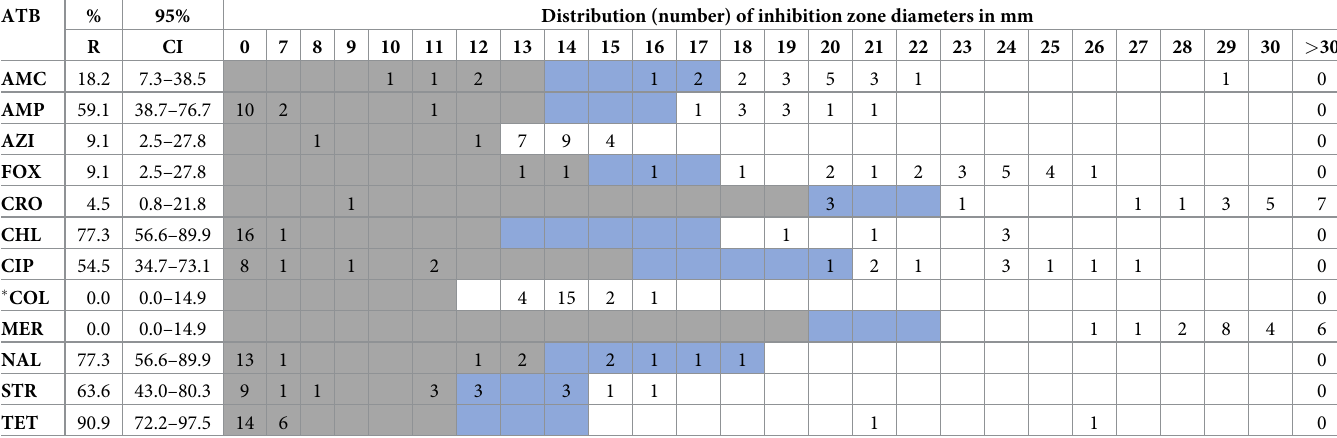
Table 4. Distribution of inhibition zone diameters of presumptive quinolone resistant E . coli (n = 22) isolated on MacConkey agar supplemented with 0.5 μ g/mL of ciprofloxacin. ATB % 95% Distribution (number) of inhibition zone diameters in